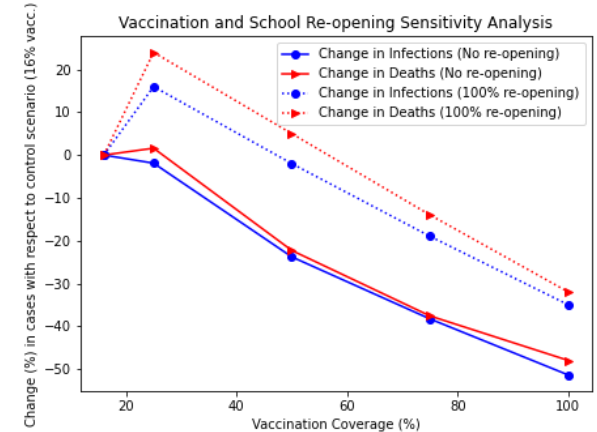
Figure 8. Comparison of School Re-opening Scenarios (no re- opening and 100% opening) Combined with Vaccination